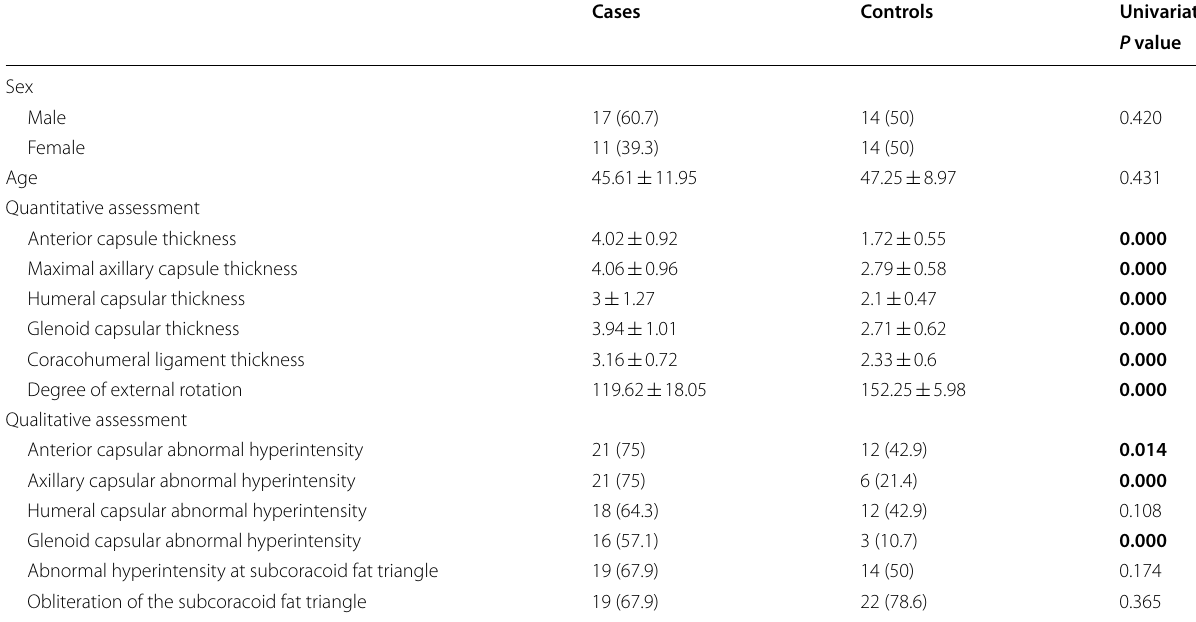
The statistically significant values were marked by